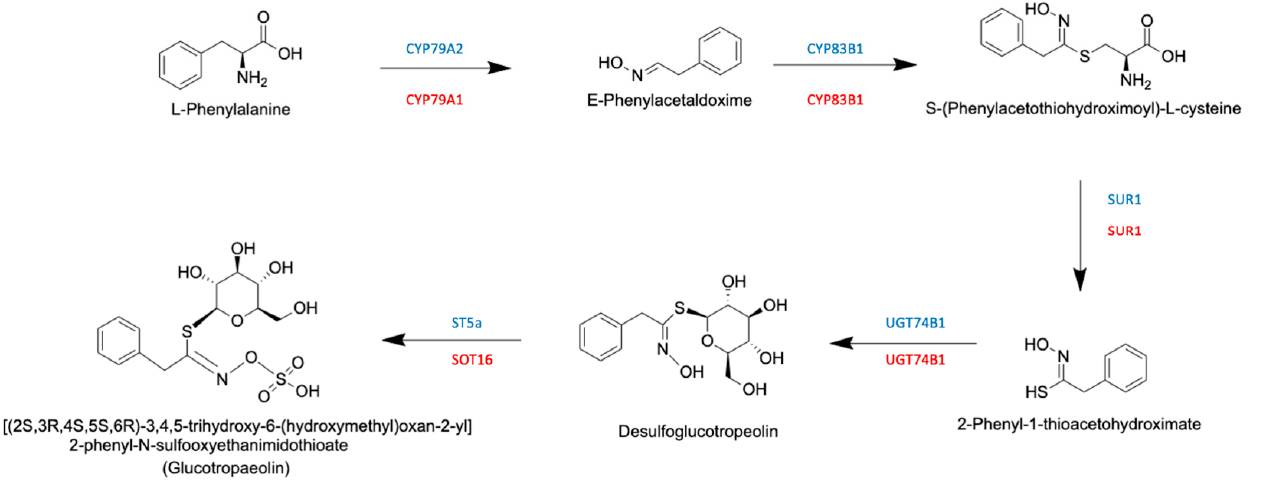
Figure 2. Proposed glucotropaeolin pathway in papaya. The fonts in blue represent known gluco- tropaeolin biosynthetic genes encoding enzymes in A. thaliana [7] , and those in red represent the corresponding papaya enzymes identified using BLASTp.